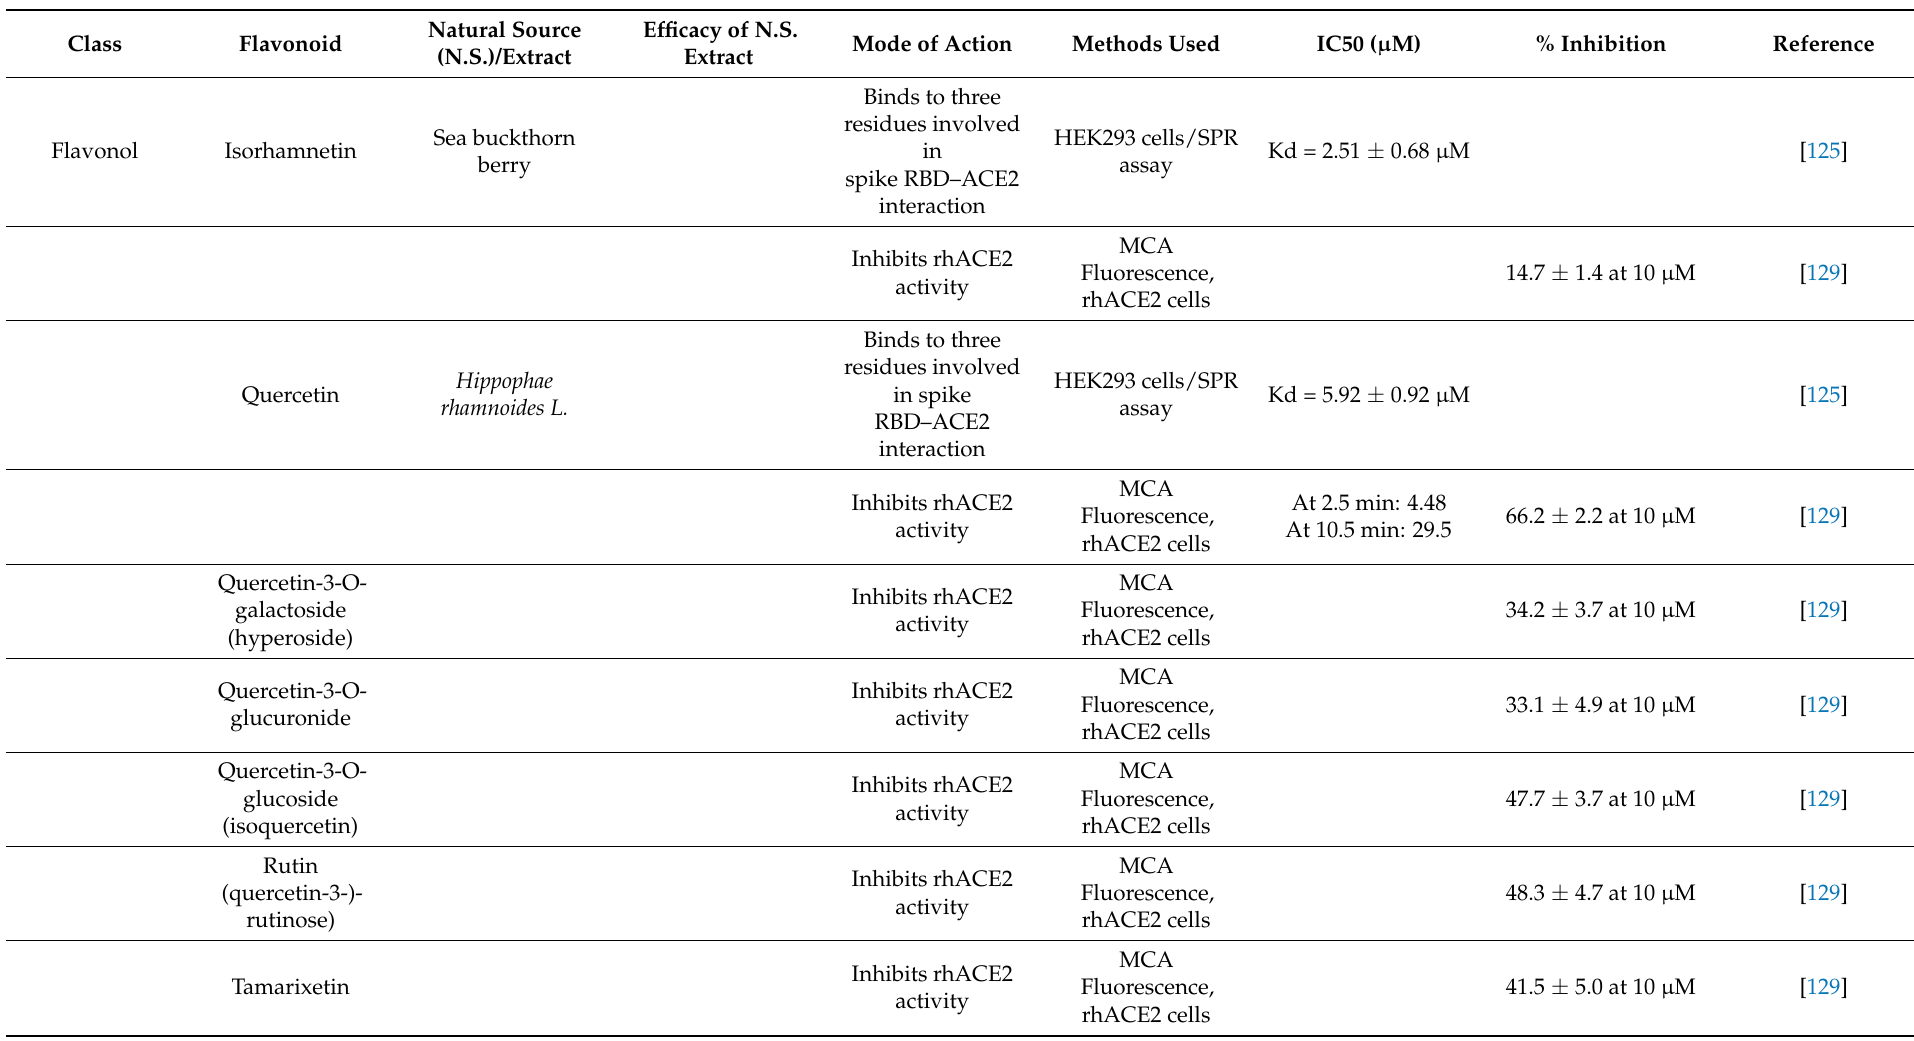
Table 3. Flavonoids with antiviral activities reported against SARS-CoV-2 spike protein–ACE2 interaction using in vitro methodologies segregated according to class. Natural Source Efficacy of N.S. Class Flavonoid Mode of Action Methods Used IC50 ( µ M) % Inhibition Reference (N.S.)/Extract Extract